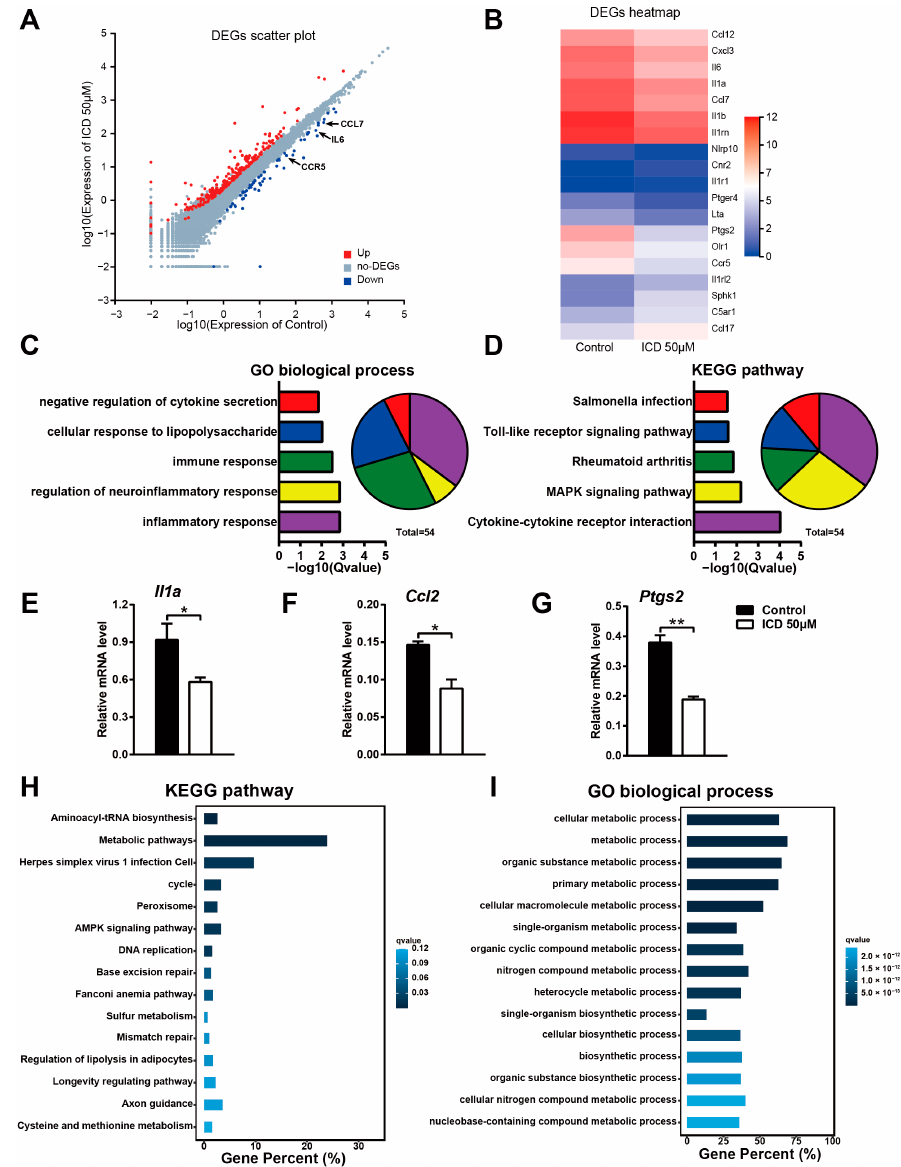
Figure 4. ICD compromises expression of inflammation pathway-related genes in LPS-activated macrophages. ( A ) Scatter plot showing gene expression changes in LPS triggered BMDMs pretreated ICD, compared to BMDMs treated with LPS alone. Downregulated genes are indicated in blue, while upregulated genes are indicated in red. ( B ) Heatmap of differential expressed genes involved in Inflammatory Response. The expression level is shown in the form of Log2(FPKM). ( C ) GO (Biological Process) analysis of the downregulated genes in ICD pretreated BMDMs. ( D ) KEGG analysis of the downregulated genes in ICD pretreated BMDMs. ( E , F , G ) The mRNA level of Il1a , Ccl2 and Ptgs2 in LPS stimulated macrophages for 6 h, pretreated with ICD or not. ( H ) KEGG anal- ysis of the upregulated genes in ICD pretreated BMDMs. ( I ) GO (Biological Process) analysis of the upregulated genes in ICD pretreated BMDMs. The mean and SD of at least three independent ex- periments are shown. * p < 0.05, ** p < 0.01 indicate significant differences between groups as deter- mined by a two-tailed paired Student’s t -test.